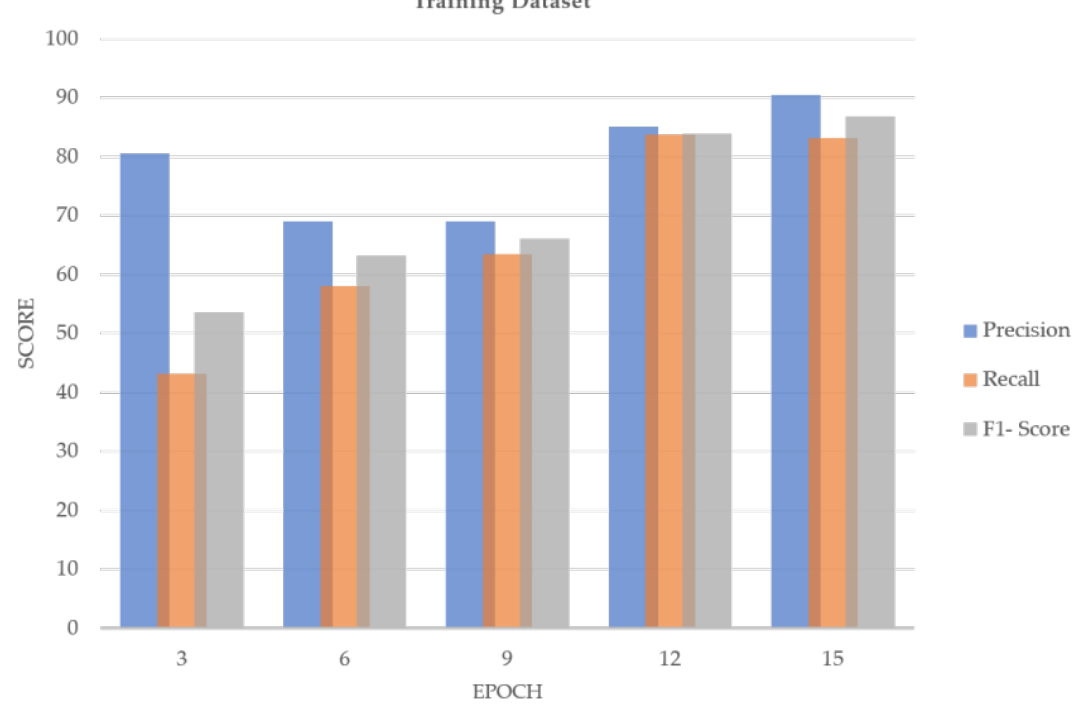
Figure 4. Train dataset: relationship between number of epoch and performance.